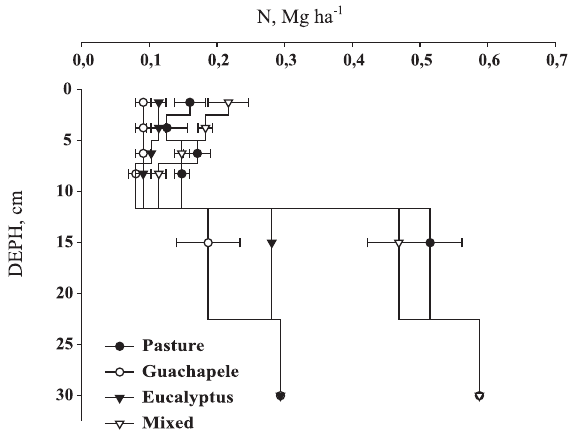
Figure 2. Estimates of N stocks in different soil layers (0–2.5, 2.5–5.0, 5.0–7.5, 7.5–10.0, 10–20 and 20– 40 cm) under pasture, pure and mixed plantations of Eucalyptus grandis and Pseudosamanea guachapele . Bars indicate standard errors of means.